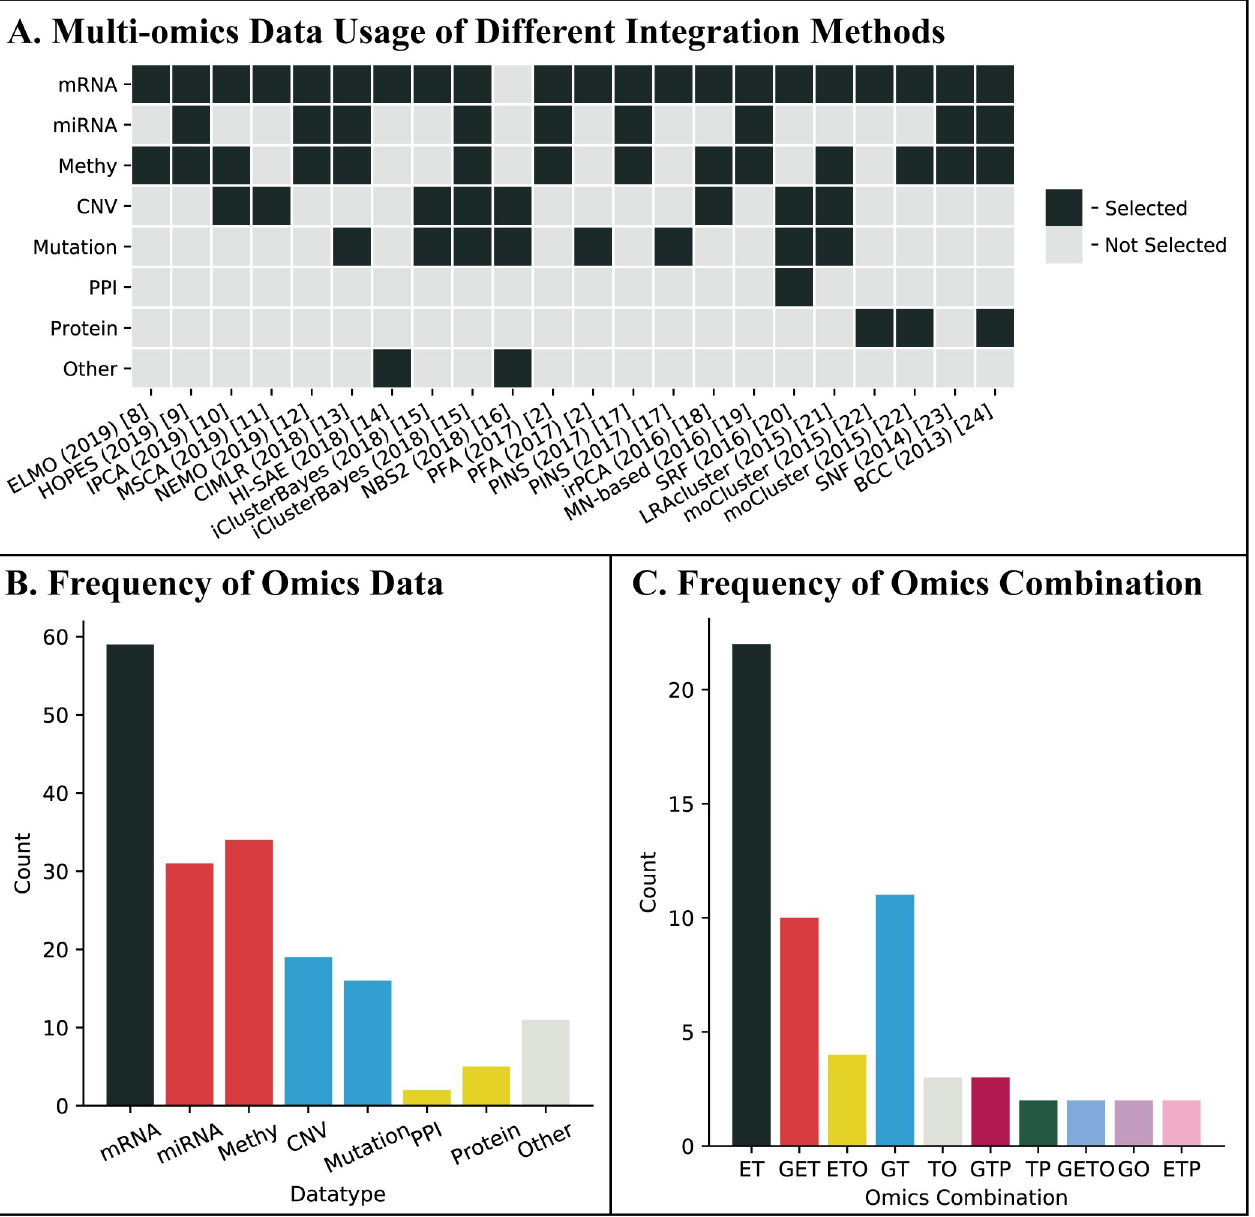
Fig 1. Summary of the data type selection of existing integration methods. (A) Multi-omics data usage of different integration methods. (B) The usage frequency of each omic data type. We use “Methy”, “mRNA”, “miRNA” and “protein” to represent DNA methylation, mRNA expression, miRNA expression, and protein expression, respectively. (C) The usage frequency of different omics combinations. We use “G”, “E”, “T”, “P” and “O” to represent genomics, epigenomics, transcriptomics, proteomics, and others, respectively.